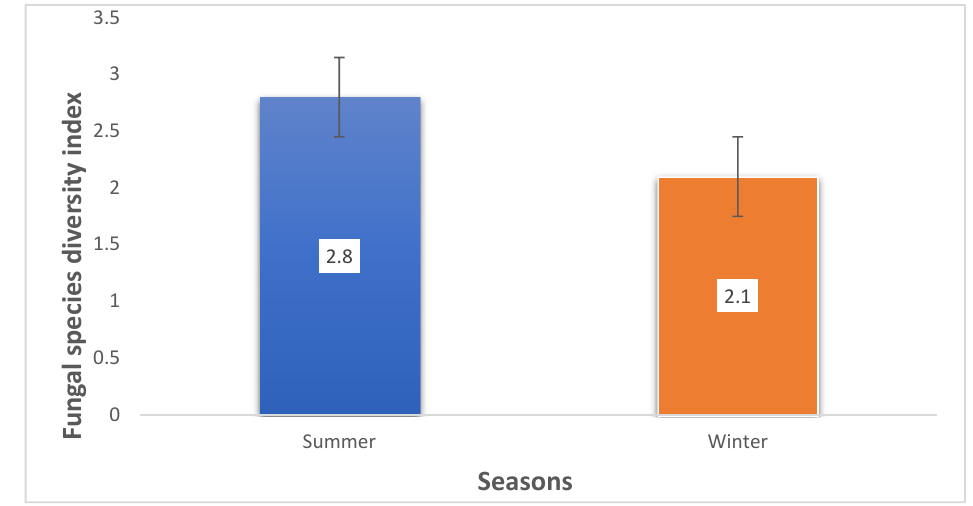
Figure 5. Shannon–Weiner (H ′ ) diversity index of isolated fungal species from SA dairy cattle feed and feed ingredients during summer and winter seasons.